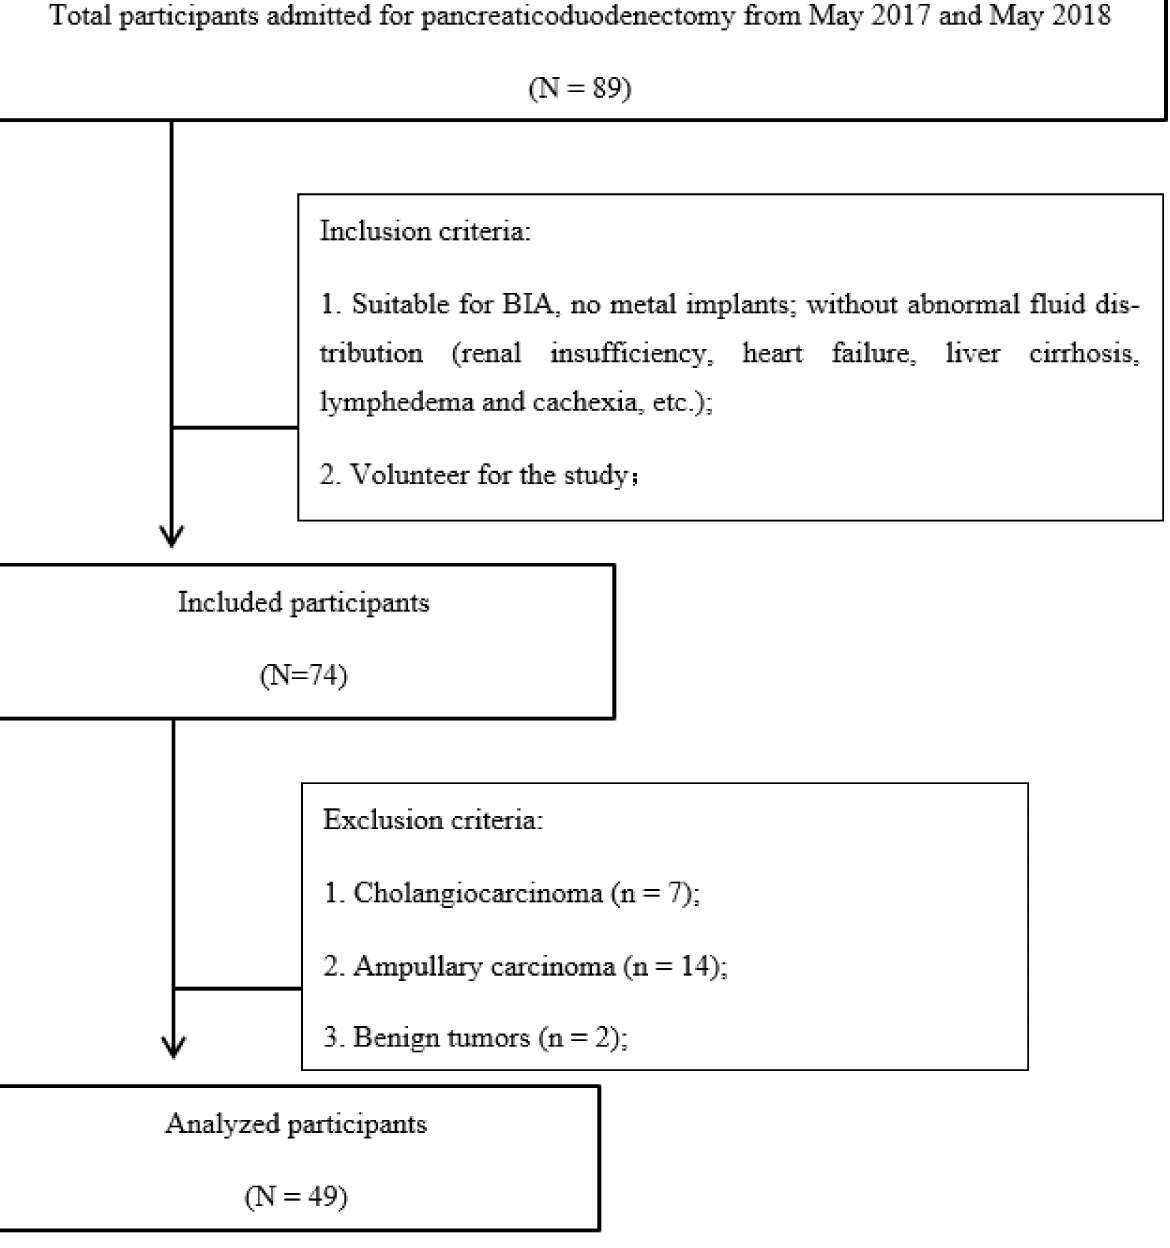
Figure 1. Selection of participants analyzed in this study. BIA, bioelectrical impedance